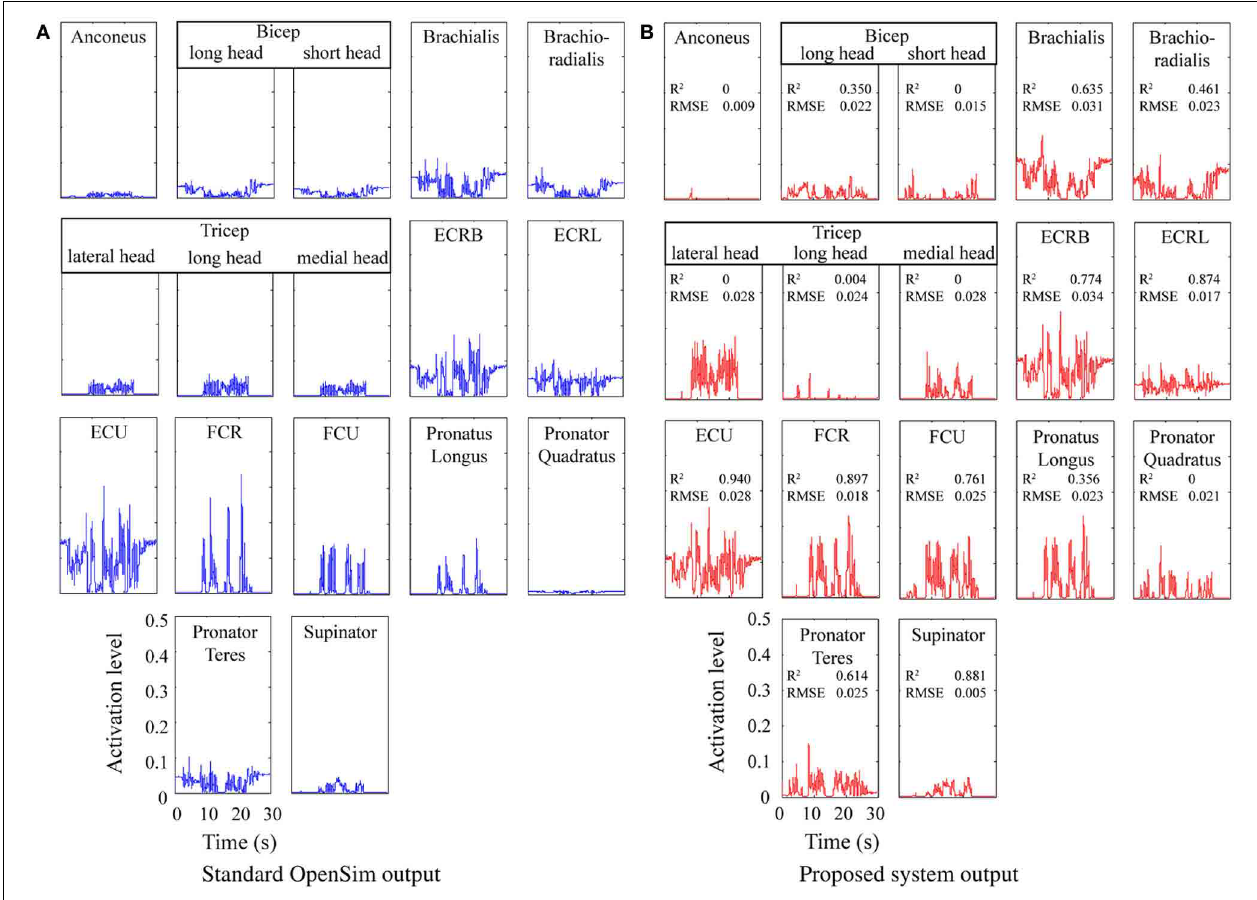
FIGURE 4 | Predicted muscle activations for an actor brushing his teeth. Coefficient of determination (R 2 ) and Root Mean Square Error (RMSE) are shown for each. (A) Standard OpenSim output. (B) Proposed system output.